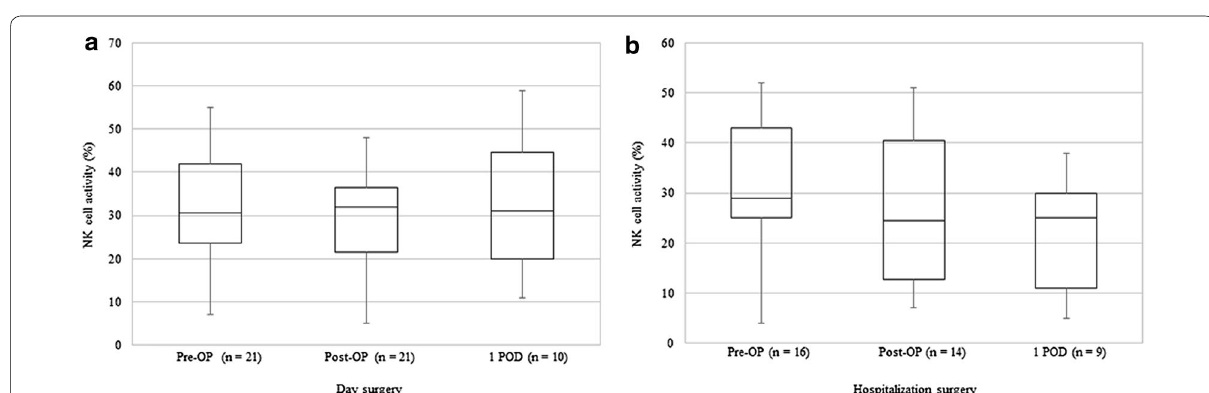
Fig. 2 Changes in NK cell activity before surgery, after surgery, and on the first postoperative day in patients undergoing day surgery ( a ) versus hospitalization surgery ( b ) for breast cancer. Median values are expressed with interquartile ranges in the box plot. Pre-OP before operation, Post-OP after operation, 1 POD first postoperative